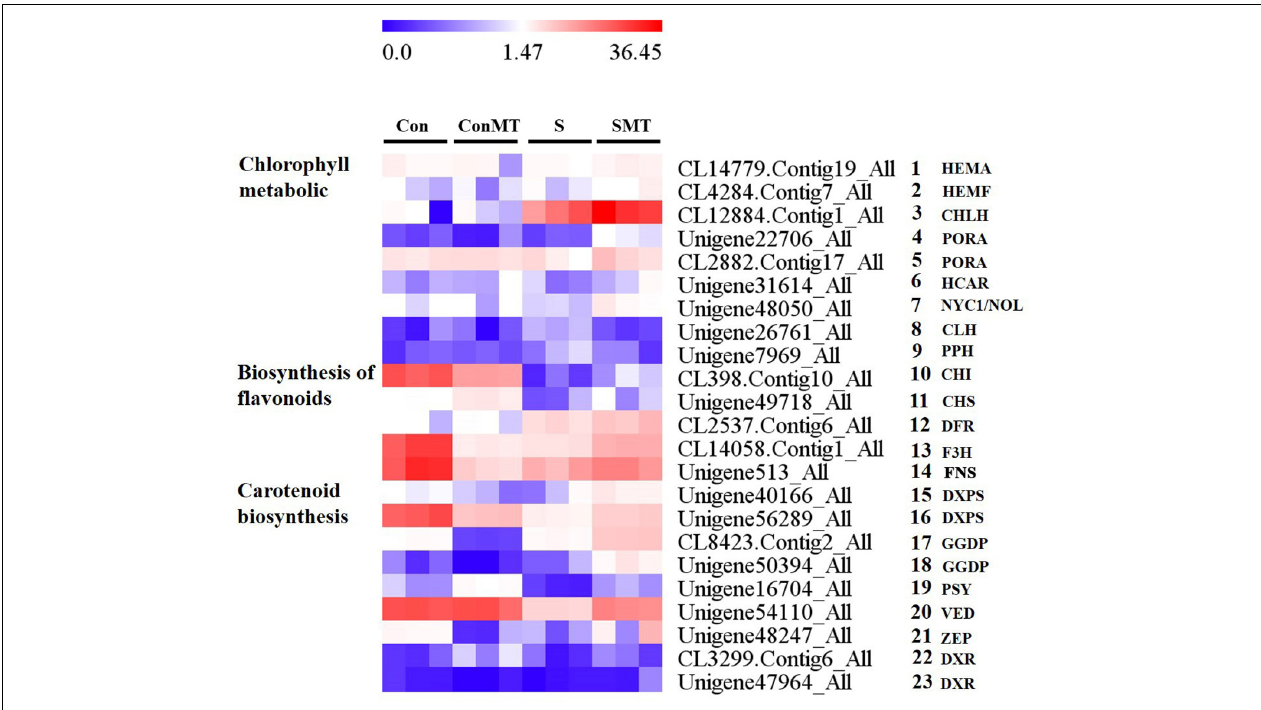
FIGURE 8 | Heat stress modified the expression profiles of chlorophyll, flavonoids, and carotenoid metabolic related genes in four comparisons. The bar represents the expression (FPKM) of each gene in Con, ConMT, S, SMT as indicated by blue, white, and red squares. Blue and red represent low and high expression, respectively. Con, control; S, heat stress; SMT, heat stress with exogenous melatonin treatment; ConMT, control with exogenous melatonin treatment. More detailed information was shown in Supplementary Table 14